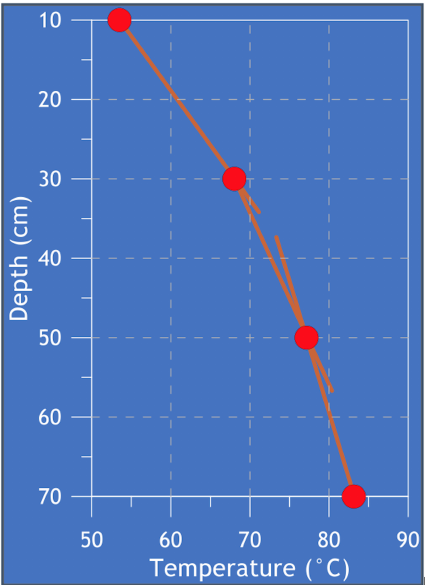
Figure 1. A typical vertical soil temperature profile of a LTF, mea- sured in the summit fumarolic field of Stromboli